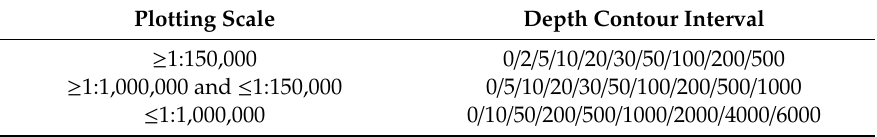
Table 5. Interval table of electronic navigation chart (ENC) with di ff erent scales. Plotting